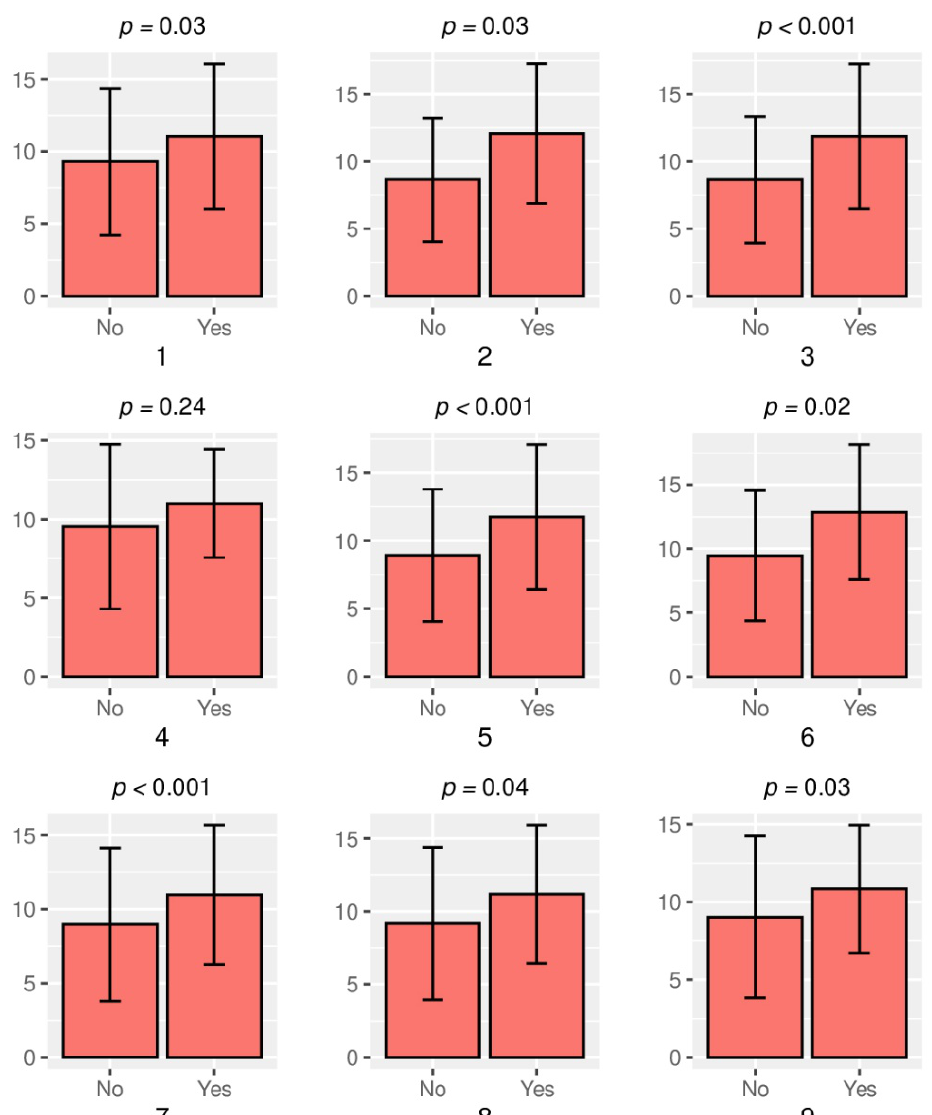
Figure 2. Analysis of the social inhibition (SI) in relation to the symptoms of SSDs. Legend: 1—TMJ Pain, 2—Headache, 3—Pain in the neck and shoulder girdle, 4—Facial pain, 5—TMJ acoustic symptoms, 6—TMJ blocking, 7—Teeth clenching, 8—Teeth grinding, 9- Increased masticatory muscles tension.